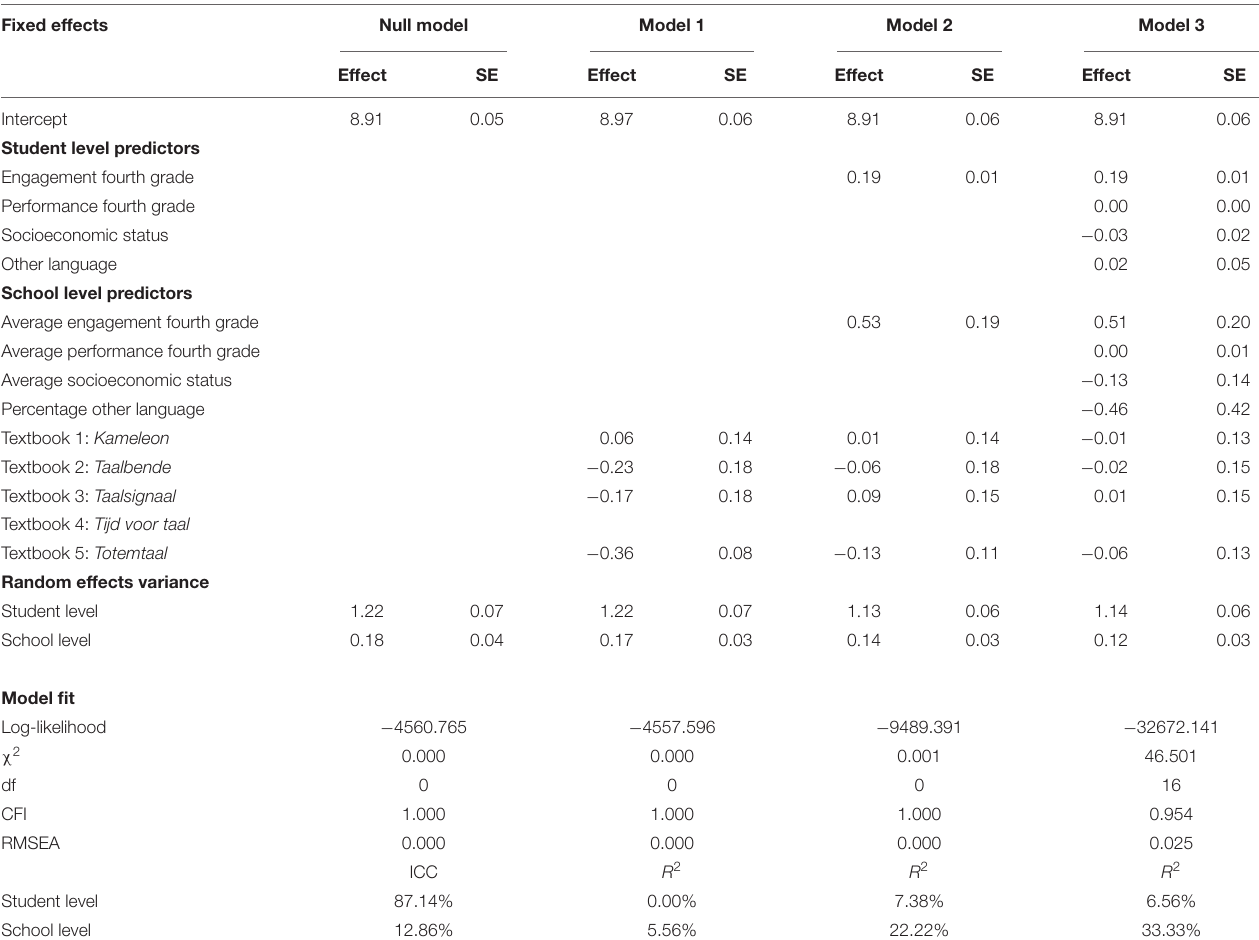
TABLE 6 | Coefficients multilevel autoregression model for reading